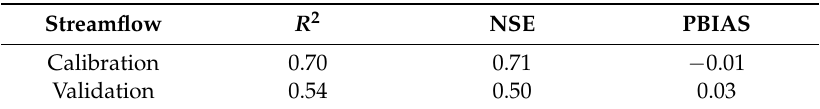
Table 2. Statistical results produced by SWAT-CUP for daily stream discharge using the parameters listed in Table 1.